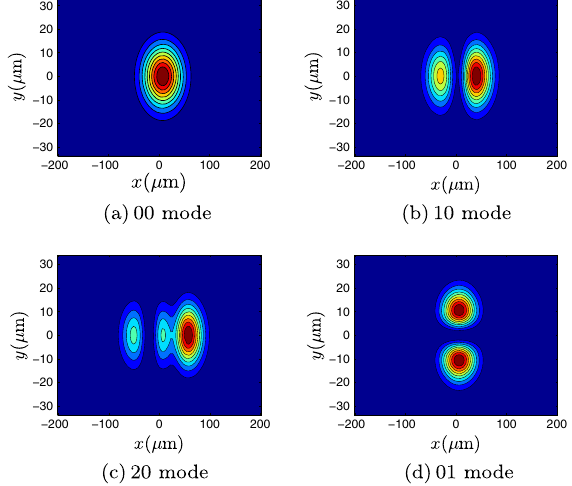
) T FIG. 4. Mode profiles from the analytical solution ( η ¼ 1 cm). Each profile is calculated for the optimum detuning of the mode. x -direction.